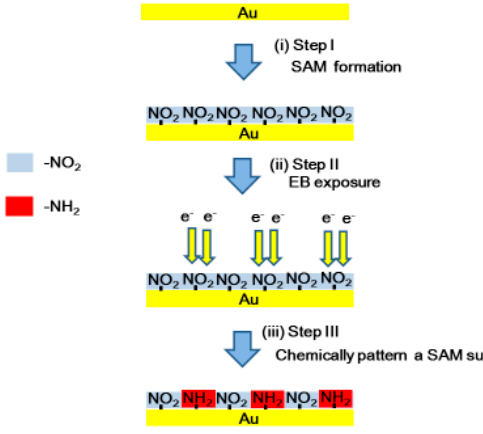
Figure 2. A scheme of the experimental steps. (Step I) SAM formation, (Step II) Patterning of SAM with EB lithography, and (Step III) EB patterning of a SAM, which induces transition of the SAM terminal functional aromatic NO 2 moieties to aromatic NH 2